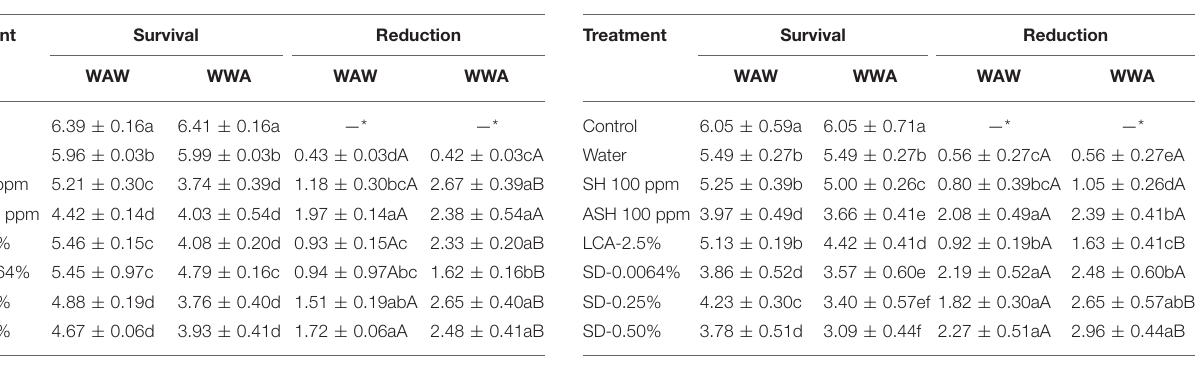
TABLE 5 | Survival and reduction of Enterococcus faecium on cucumbers (log CFU/cucumber) by triple-wash procedure WAW or WWA in water, SH (100 ppm,